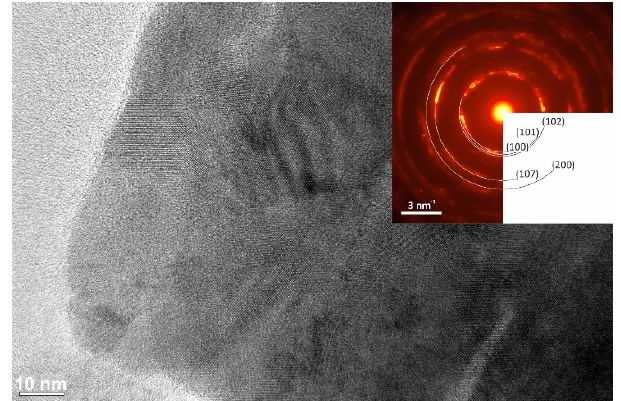
Figure 7. HRTEM image of the structure of the CuSe-VM sample, acquired at magnification 200 kx, corresponding to the SAED pattern (inset).